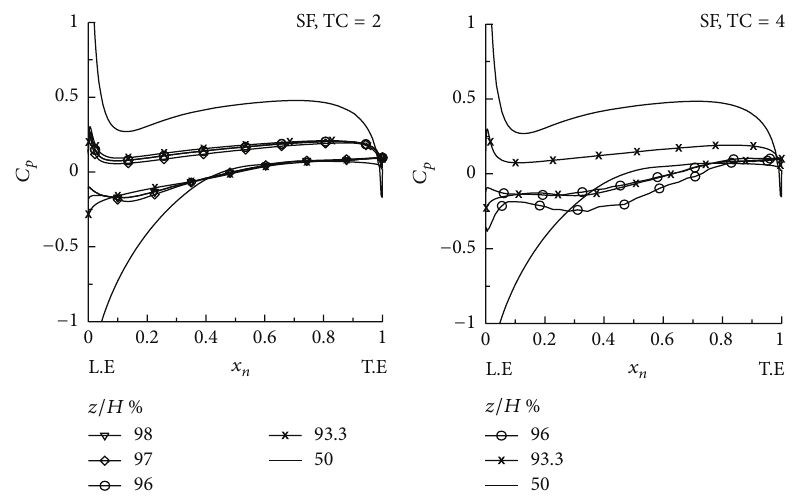
Figure 6: 𝐶 𝑝 at tip end with uniform flow and shear flow, for TC = 0 to